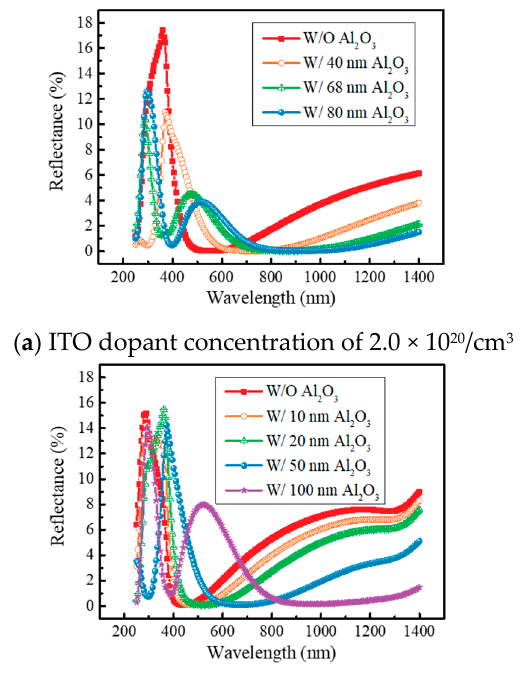
Figure 4. Reflectance results performed with the Al 2 O 3 /ITO/Si structure via OPAL 2 simulation. The dependence of reflectance on Al 2 O 3 layer thickness at different ITO dopant concentrations is shown. ITO dopant concentration: ( a ) 2.0 × 10 20 , ( b ) 4.9 × 10 20 , and ( c ) 6.1 × 10 20 /cm 3